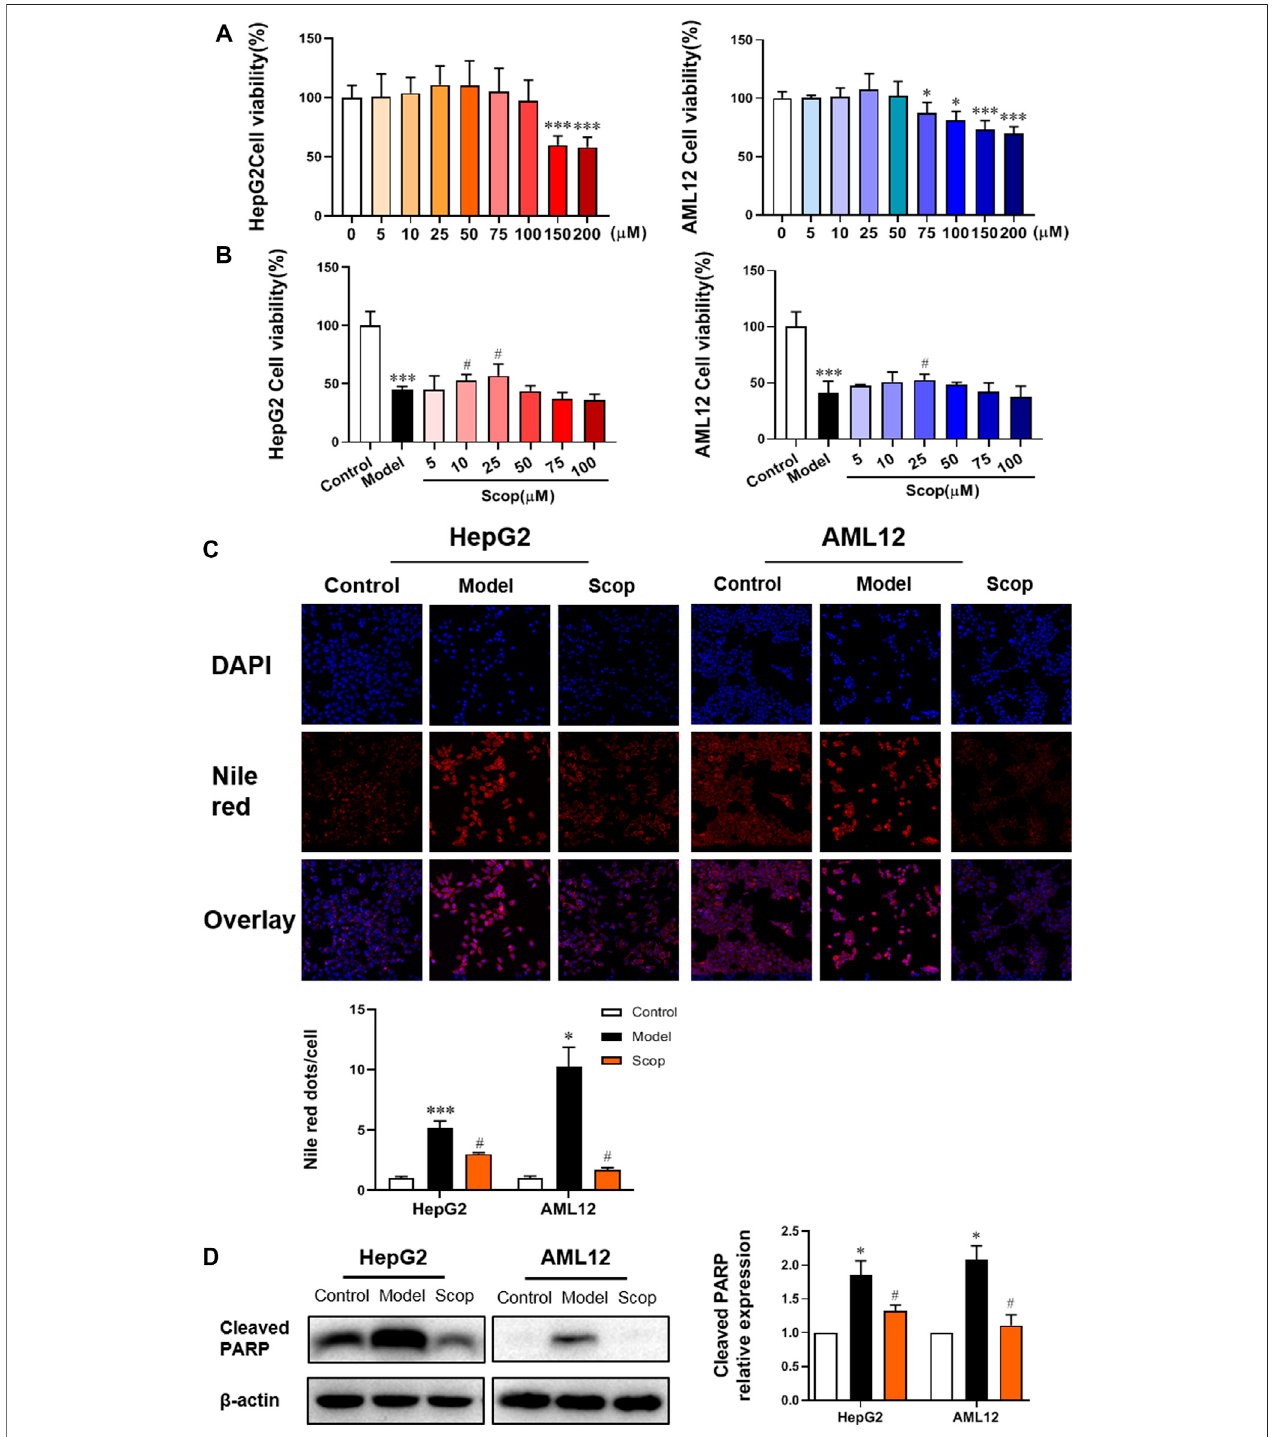
FIGURE 3 | Scoparone reversed PA-induced lipotoxic injury of hepatocytes. (A) The effect of different concentrations of Scoparone on the viability of HepG2 and AML12 cells.* p < 0.05,*** p < 0.001vs.Scop0 µM. (B) TheeffectofdifferentconcentrationsofScoparone ontheviabilityofHepG2and AML12cellswithPAinduction. (C) DAPI and Nile Red double staining of HepG2 and AML12 cells. (D) The effect of Scoparone on Cleaved PARP protein level in HepG2 and AML12 cells. * p < 0.05, *** p < 0.001 vs. Control; # p < 0.05 vs. Model.